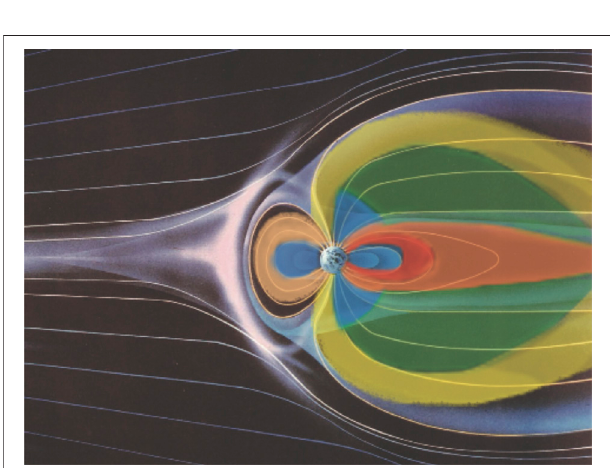
FIGURE 3 | A schematic look at the fl ow of ionospheric plasma from the Earth upward into the magnetosphere to form the different regions of hot